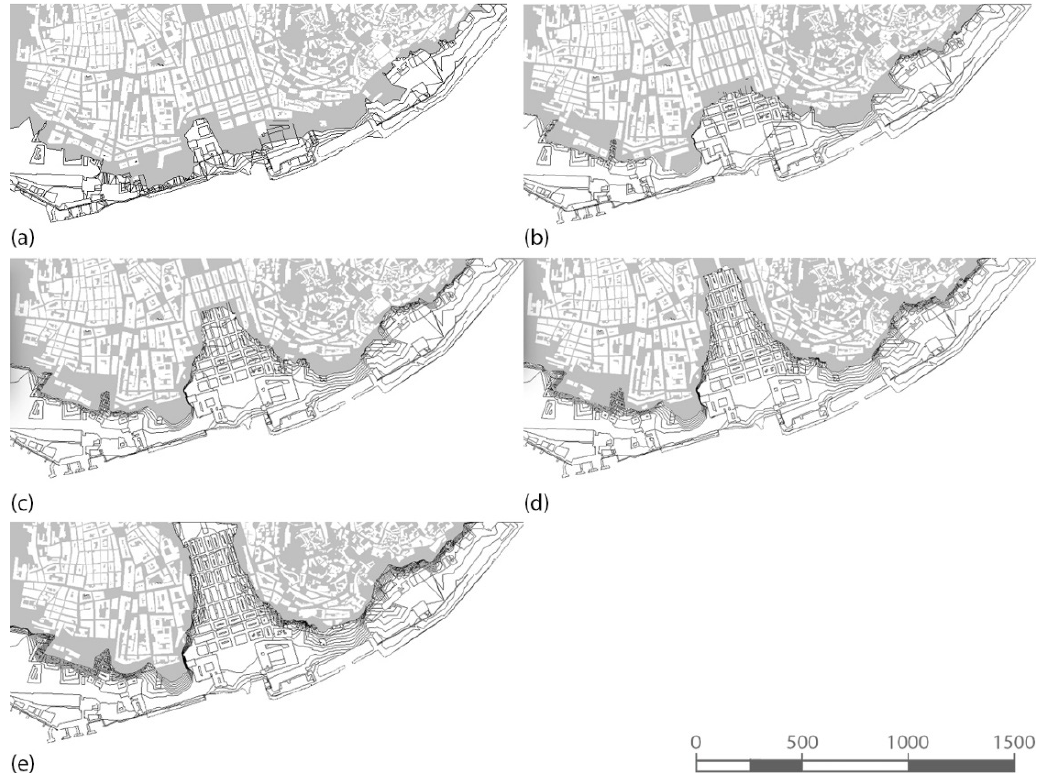
Figure 5. Exposure at different altitudes. The image shows, in grey, the position of the reference plane set at the following altitudes: ( a ) 4 m; ( b ) 6 m, ( c ) 8 m; ( d ) 10 m; and ( e ) 12 m. Vulnerability Map. This map groups building on the basis of the five levels of vul ‐ nerability defined in Section 2.1.3 of this article.